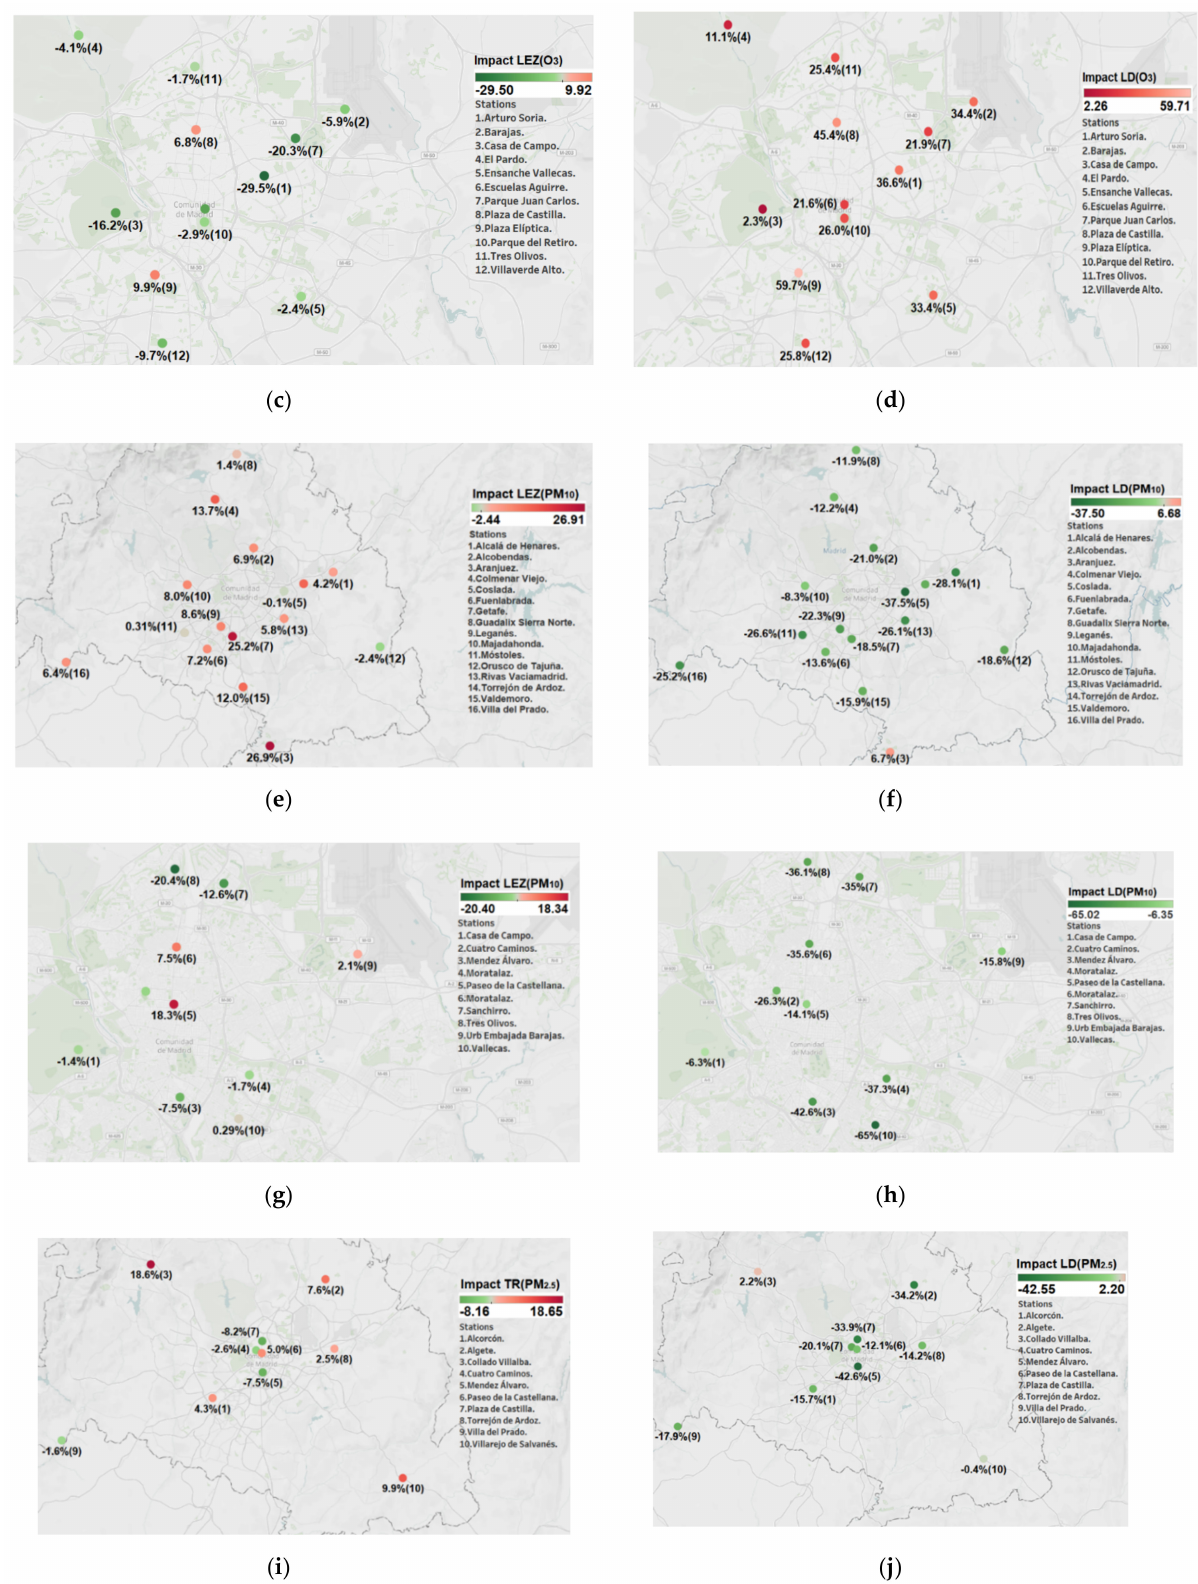
Figure 6. The left-hand side contains the estimates of the LEZ effect by monitoring station, while the right-hand side captures the LD effect on pollution within and outside Madrid city; ( a , b ) O 3 in CM, ( c , d ) O 3 in Madrid city, ( e , f ) PM 2.5 in CM, ( g , h ) PM 2.5 in Madrid city ( i , j ) PM 2.5 in